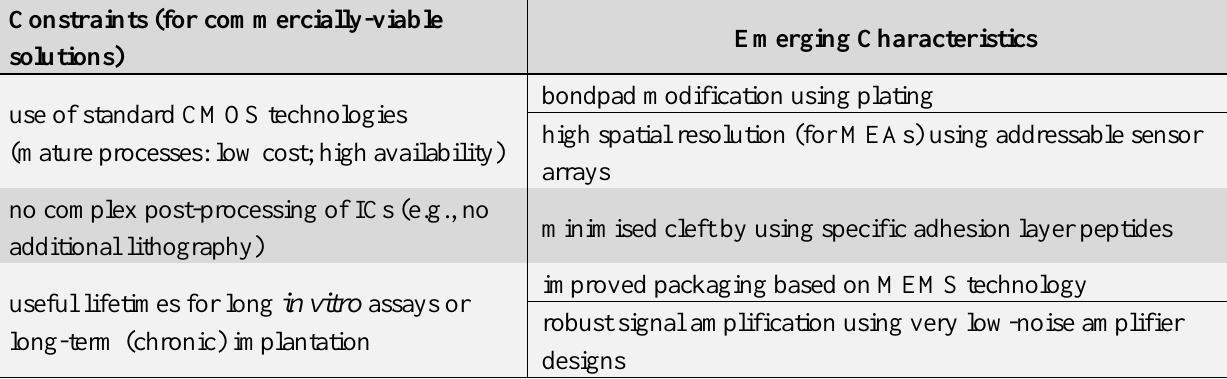
Table 3. Themes for commercially-viable CMOS neuronal interfaces